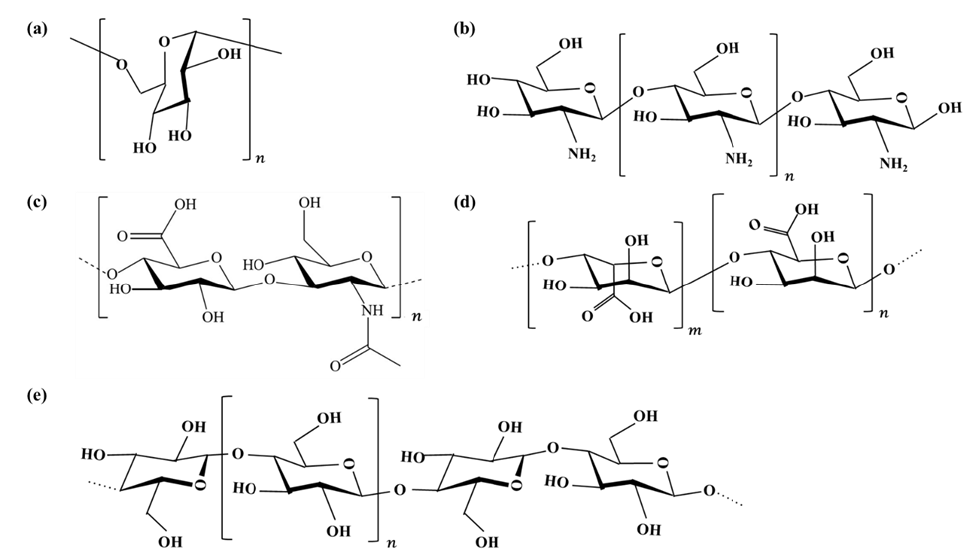
Figure 2. Chemical structural formulas of common polysaccharides: ( a ) Dextran; ( b ) Chitosan; ( c ) Hyaluronic acid; ( d ) Alginic acid; ( e ) Cellulose.